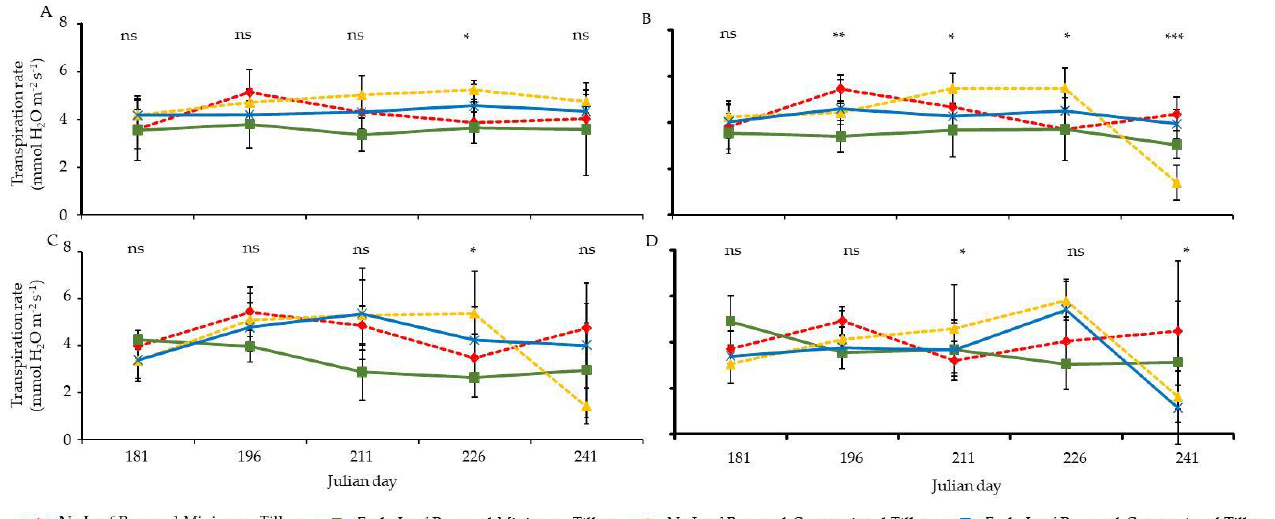
Figure 4. Transpiration rate measured in 2017 (( A ) primary leaves, ( B ) lateral leaves) and 2018 (( C ) primary leaves, ( D ) lateral leaves) for the four combinations analyzed. For each year, *, ** and *** represent significant differences at p < 0.05, 0.01 and 0.001, respectively, and ns indicates no significant differenc e, based on Tukey’s HSD test (± standard deviation). Table 2. Tukey’s post-hoc test ANOVA on yield characteristics and main berry quality attributes. Interactions are indi- cated by: * Significant p < 0.05; ** Significant p < 0.01; *** Significant p < 0.001.